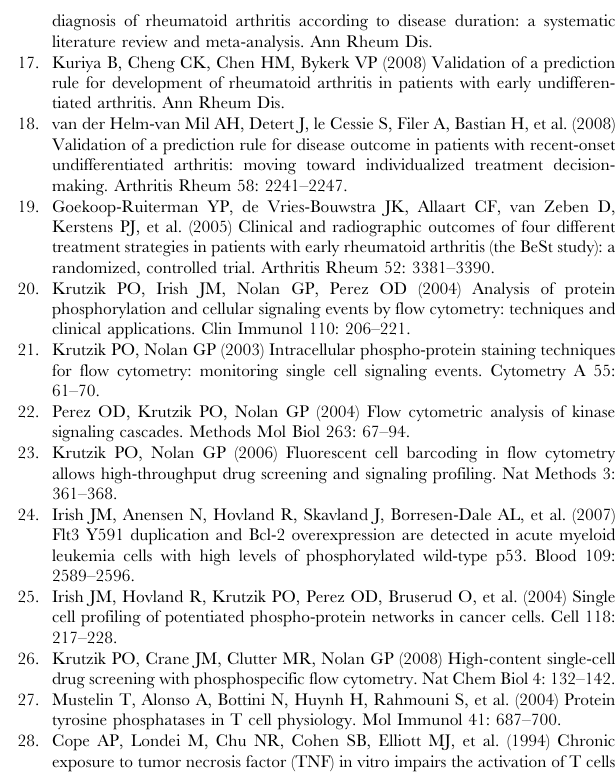
Figure S6 The effects of Plaquenil therapy on phospho-signaling in ERA PBMCs. PB MFI values for each of the indicated phospho-epitopes are plotted to compare ERA patients on plaquenil (n =22 except for p-AKT, p-BTK and p-H3 where n =14; open circles) versus those not (n= 15 except for p-JNK, p- p38 and p-STAT3 where n= 14 and p-AKT, p-BTK and p-H3 where n= 9; closed circles). Data are shown for each of the indicated cell populations. Significant differences were calculated by Student’s t test (p , 0.05). Figure S7 The effects of Sulphasalazine therapy on phospho- signaling in ERA PBMCs. PB MFI values for each of the indicated phospho-epitopes are plotted to compare ERA patients on sulfasalazine (n= 9 except for p-AKT, p-BTK and p-H3 where n =4; open circles) versus those not (n =28 except for p-JNK, p- p38 and p-STAT3 where n= 27 and p-AKT, p-BTK and p-H3 where n= 19; closed circles). Data are shown for each of the indicated cell populations. Significant differences were calculated by Student’s t test (p , 0.05). Figure S8 The effects of IA steroid therapy on phospho- signaling in ERA PBMCs. PB MFI values for each of the indicated phospho-epitopes are plotted to compare ERA patients on intra- articular (IA) steroids (n= 17 except for p-JNK, p-p38 and p- STAT3 where n= 16 and p-AKT, p-BTK and p-H3 where n =11; open circles) versus those not (n =20 except for p-AKT, p- BTK and p-H3 where n =12; closed circles). IA steroids included DepoMD, Kenalg1 and dexamethasone. Data are shown for each of the indicated cell populations. Significant differences were calculated by Student’s t test (p , 0.05).